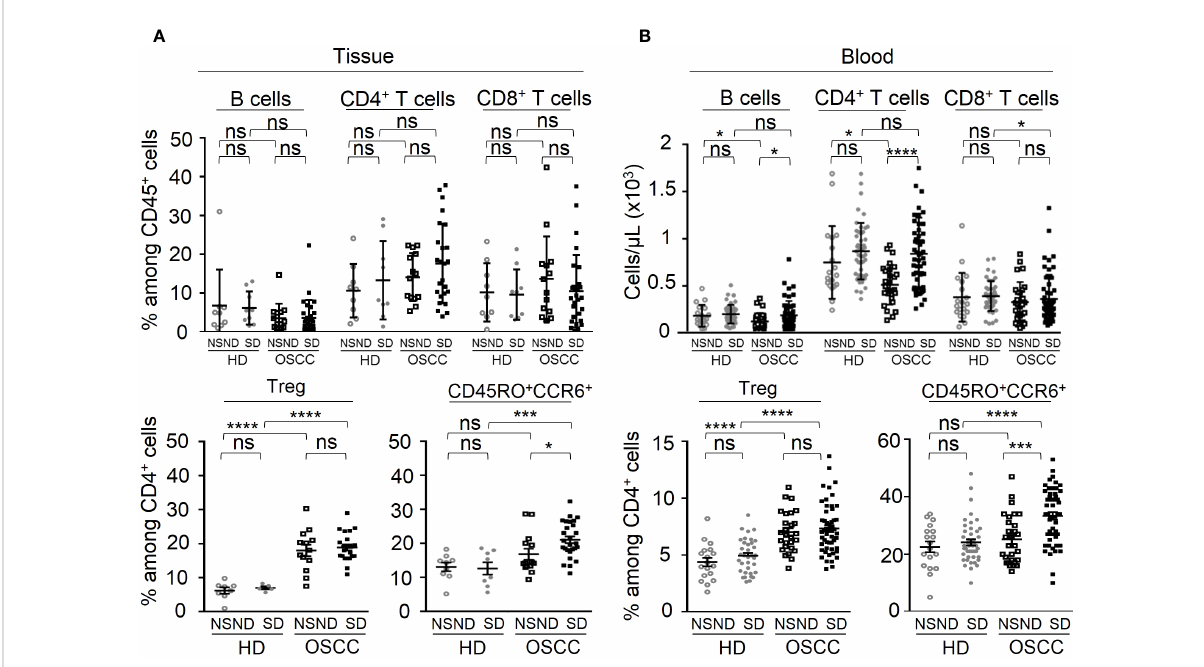
FIGURE 3 Analysis of the adaptive immune contents of tumor tissue and blood samples from OSCC patients and healthy donors according to risk factors (SD vs NSND). Data are presented either as percentages of cells among CD45 + cells or CD4 + T cells, or as absolute number of cells per µL of blood. (A) Tissue analysis and (B) Blood analysis, of B lymphocytes, CD4 + and CD8 + T cells among CD45 + cells (upper panels), and of Treg and CD45RO + CCR6 + cells among CD4 + T cells (lower panels) of OSCC patients and healthy donors depending on risk factors exposition. Data from SD ( ■ ) and NSND ( □ ) patients were compared to those obtained from SD ( ● ) and NSND ( ○ ) healthy donors (14 tumors and 28 blood samples from NSND OSSC patients; 30 tumors and 59 blood samples from SD OSCC patients; 9 normal gingival tissues and 19 blood samples from NSND healthy donors; 9 normal gingival tissues and 34 blood samples from SD healthy donors). For statistical analysis, a Mann-Whitney test was used. Bars represent the standard error of the mean (SEM). *p ≤ 0.05; *** p ≤ 0.001; ****p ≤ 0.0001; ns: not signi fi